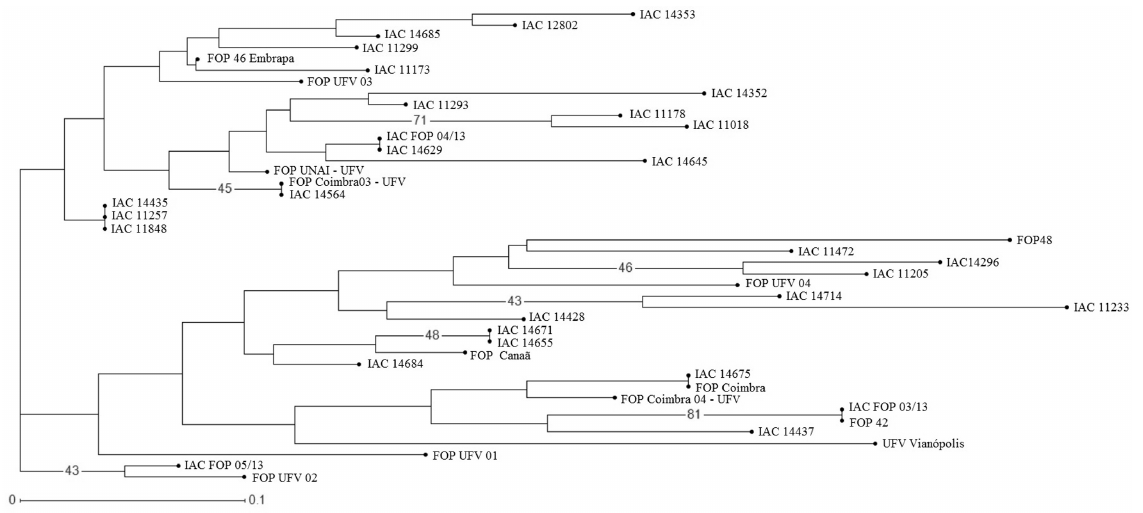
Figure 1 - Dendrogram generated using genotyping data with 15 SSRs using the unweighted neighbor-joining method, as implemented in the DARwin software. Bootstrap node support was represented in percentages and showed clustering stability. Numbers (%) on the branches correspond to bootstrap values above